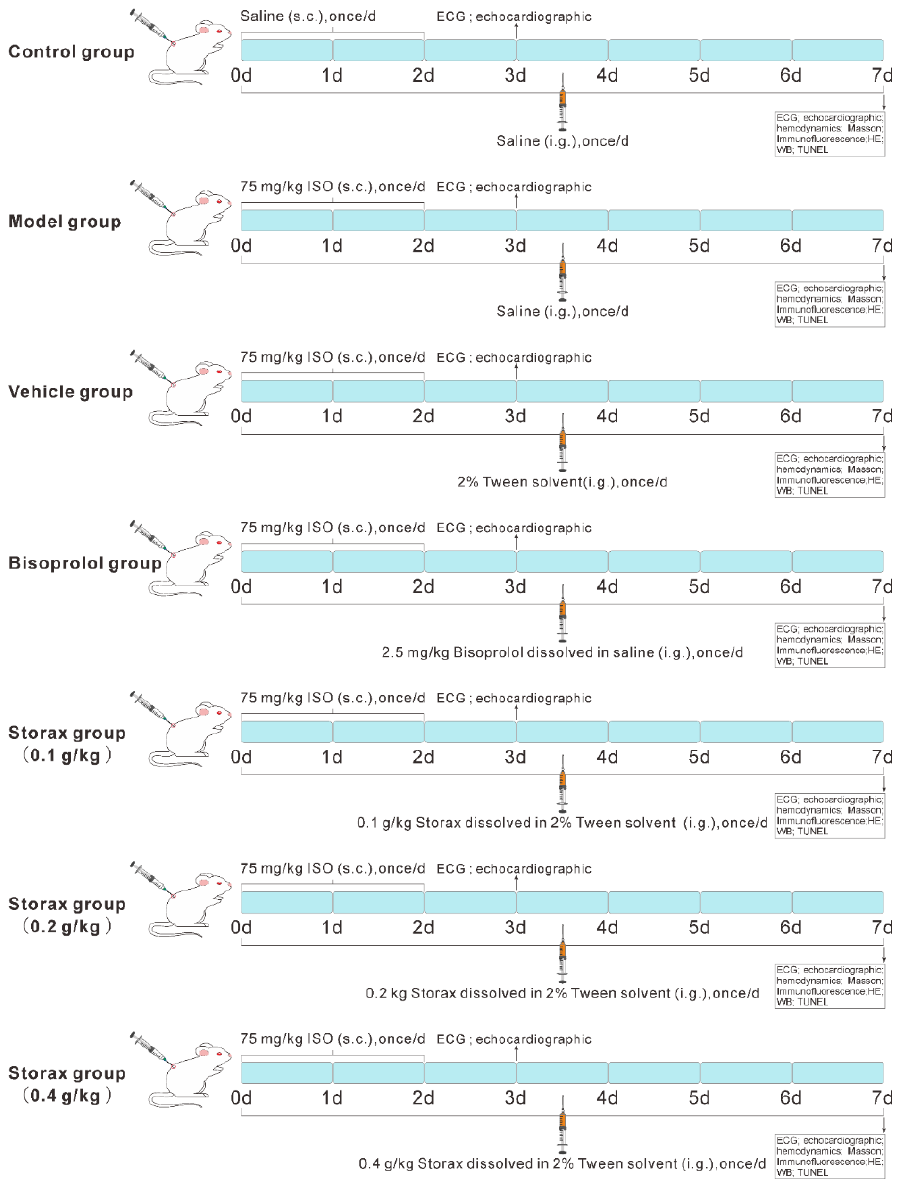
Figure 10. Experimental design for cardioprotective study of storax in rats.